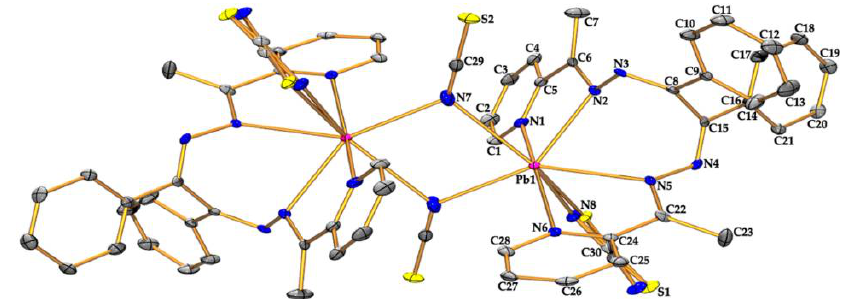
Figure 1. View of the asymmetric unit of compound ( 1 ) with a partial atom numbering scheme. Hydrogen atoms are omitted for clarity. The unlabeled counterpart is generated through the symmetry operation. Thermal ellipsoids are drawn at the 30% probability level.